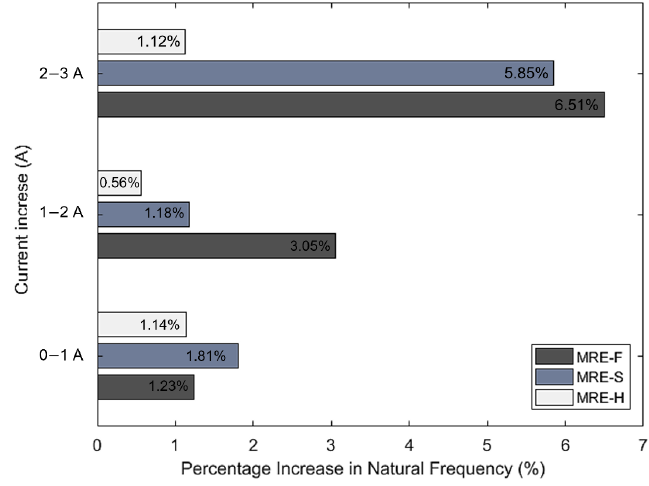
Figure 14. Percentage increase in natural frequency for MRE-F, MRE-S, and MRE-H.